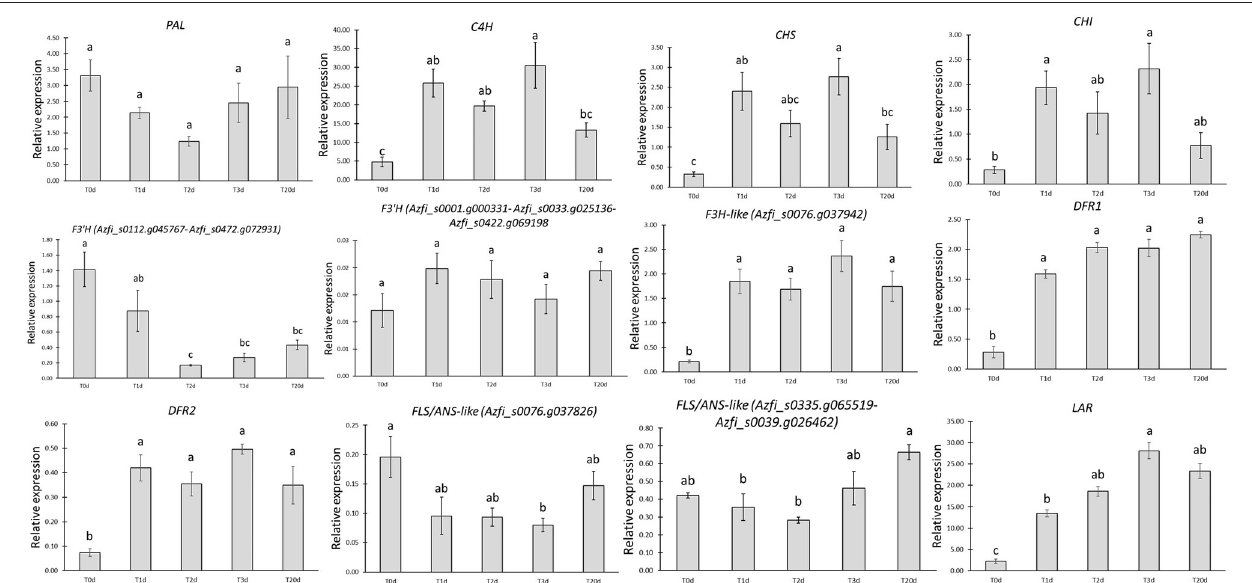
FIGURE 8 | Relative expression of early and late genes/gene families in the time-course experiment. The relative expression of each gene/gene family is calculated using the (2 − 1 Ct ) algorithm. Significant differences determined by ANOVA followed by Tukey’s multiple comparison test ( P < 0.05 for both) are indicated by different